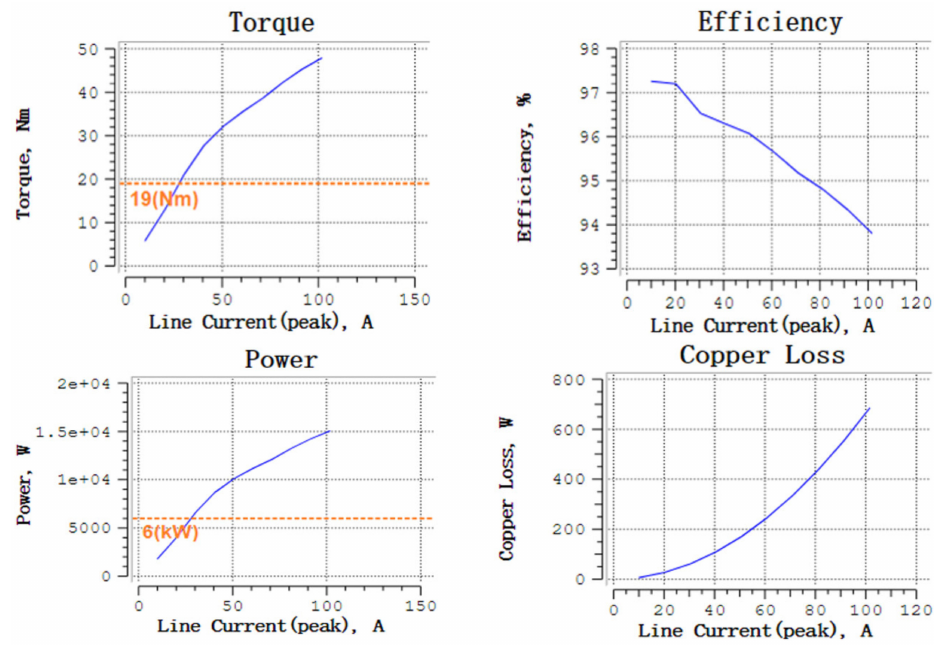
Figure 5. Motor performance index.